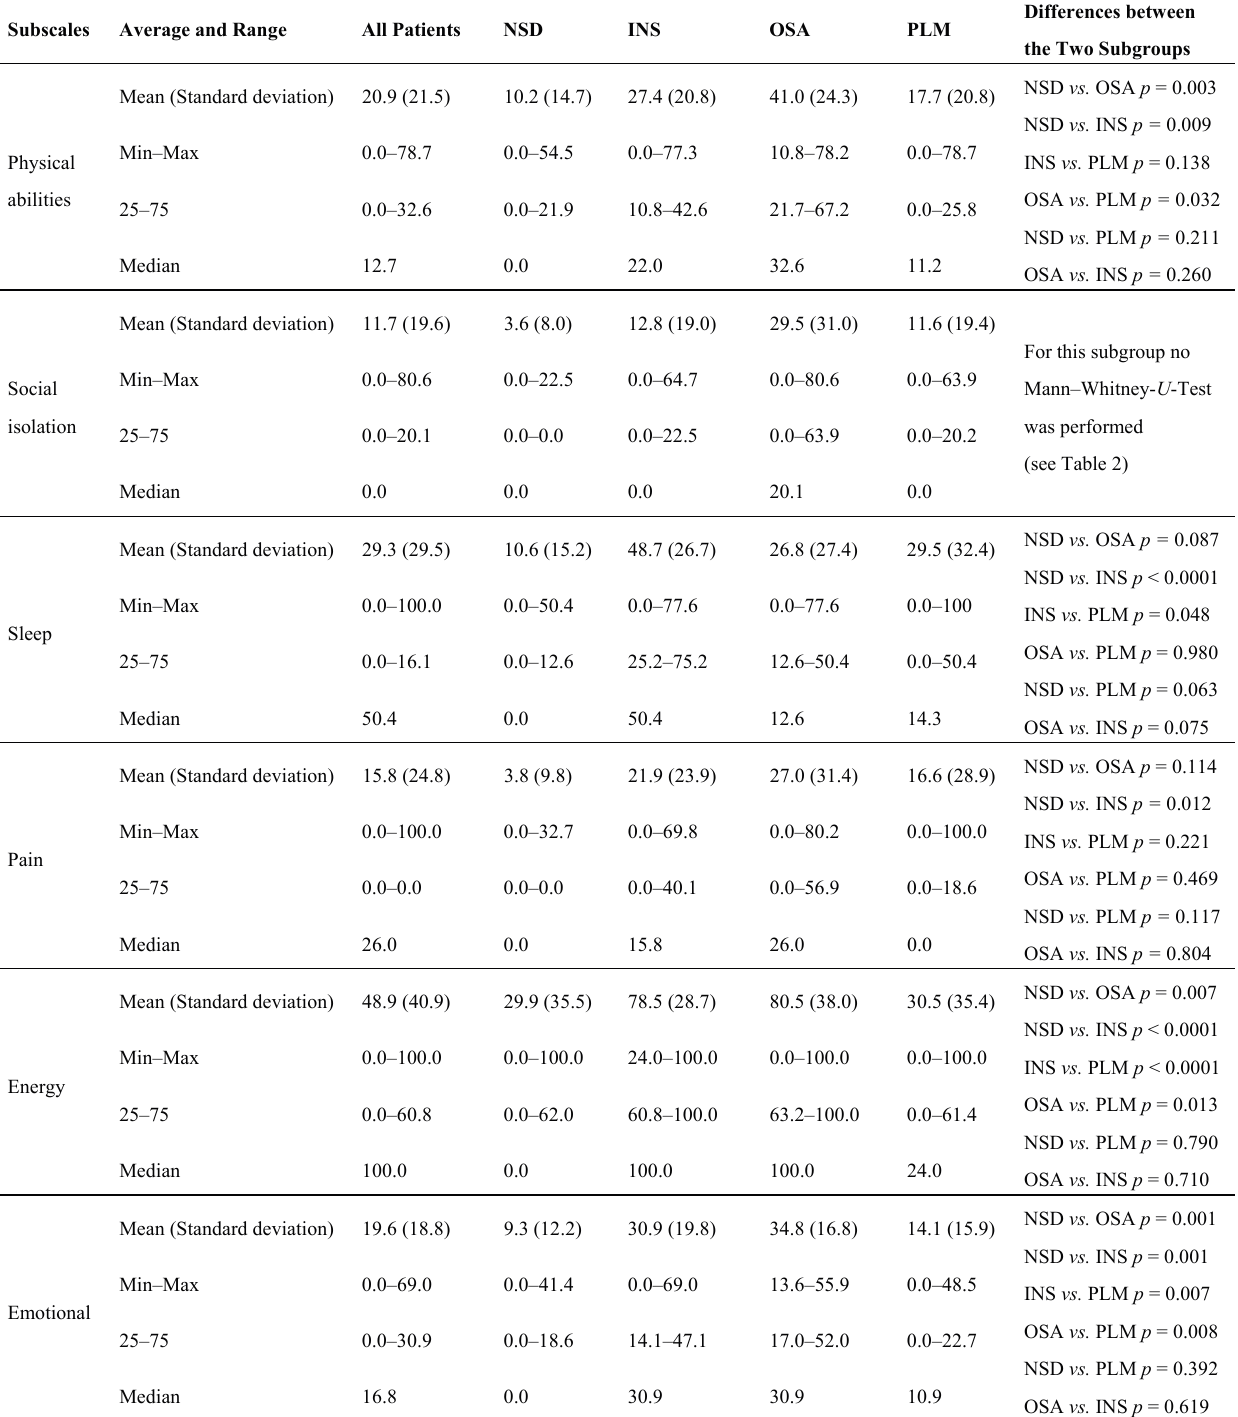
Table 4. NHP subscale values in all patients and in the four